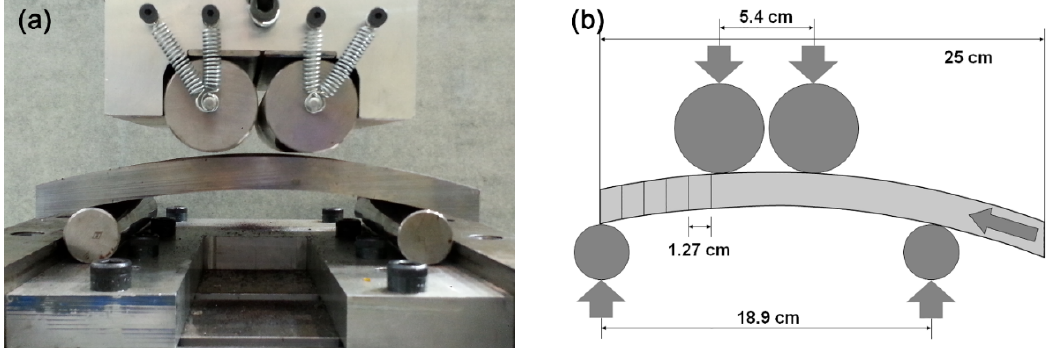
Figure 1. ( a ) A sample pipe prepared for flattening in the four point bending apparatus and ( b ) a schematic diagram of the test configuration and sample movement during flattening. The vertical lines in the sample cross-section indicate the position of the sample aligned along the left-lower roller per each flattening step.